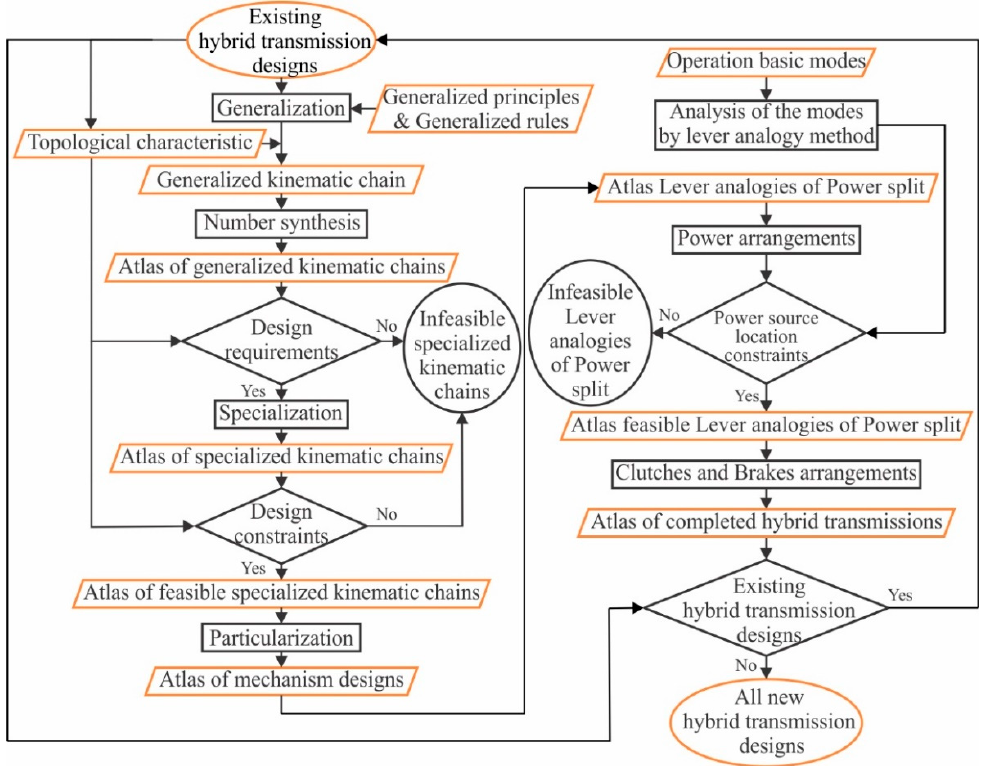
Figure 2. Design procedure for hybrid transmissions.